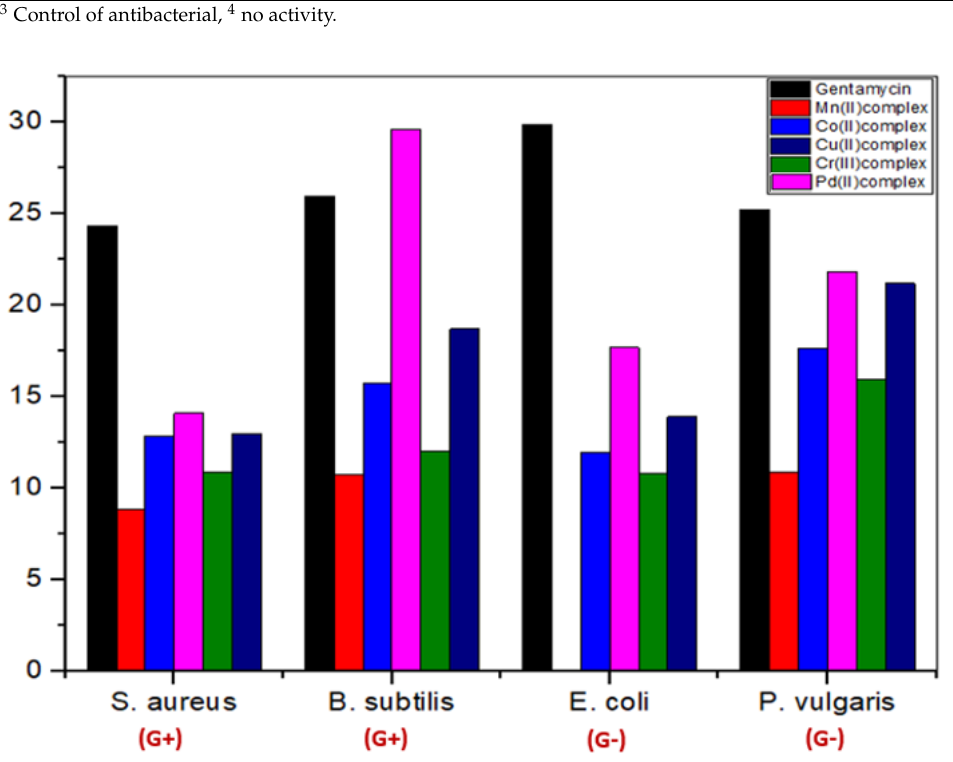
Figure 14. Antibacterial activities of the gentamycin and five metal complexes against S. aureus, B. subtilis, Escherichia coli and P. vulgaris.